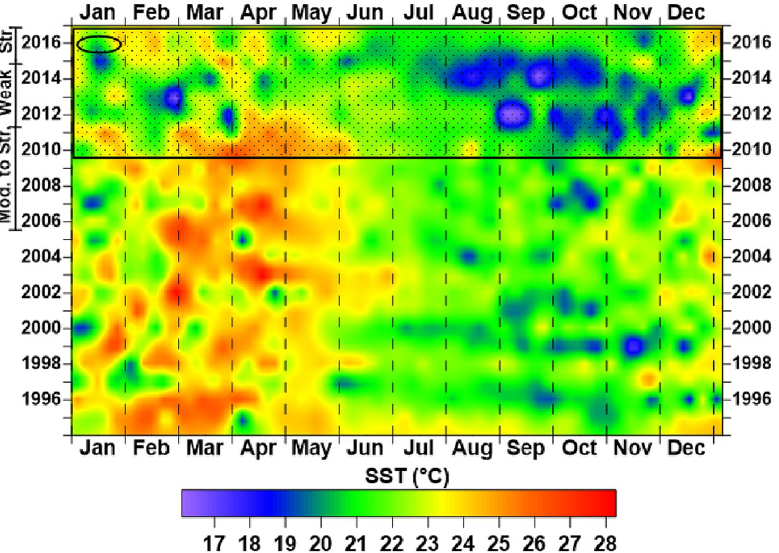
Figure 6. Temperature Grid of the Sea Surface Temperature (SST) at the Cabo Frio upwelling obtained by Kriging the SST data (1995–2016). Blue spots (cold): longer-term and intensity of the upwelling phenomenon. Red blots (hot): longer-term and intensity of temperature anomalies. Ellipse: SST in the period correspondent to the sampling campaign. Hachured rectangle: Str—increased wind magnitude period (from 2010 to 2016); Weak—absence of the events of a mild El Niño (from 2012 to 2013); and Mod. To Str—moderate to strong winds (from 2006 to 2010).